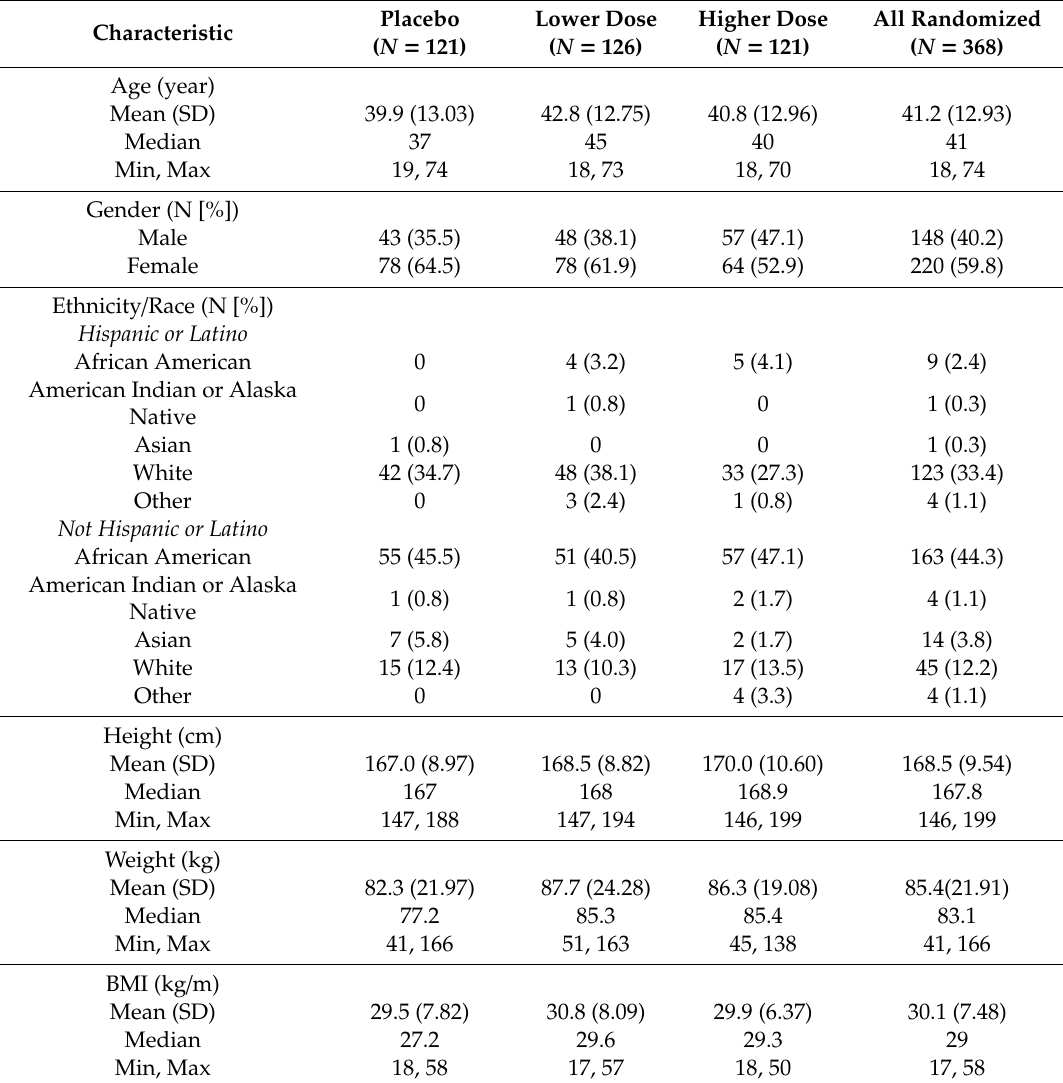
Table 2. Demographics and Baseline Characteristics (mITT